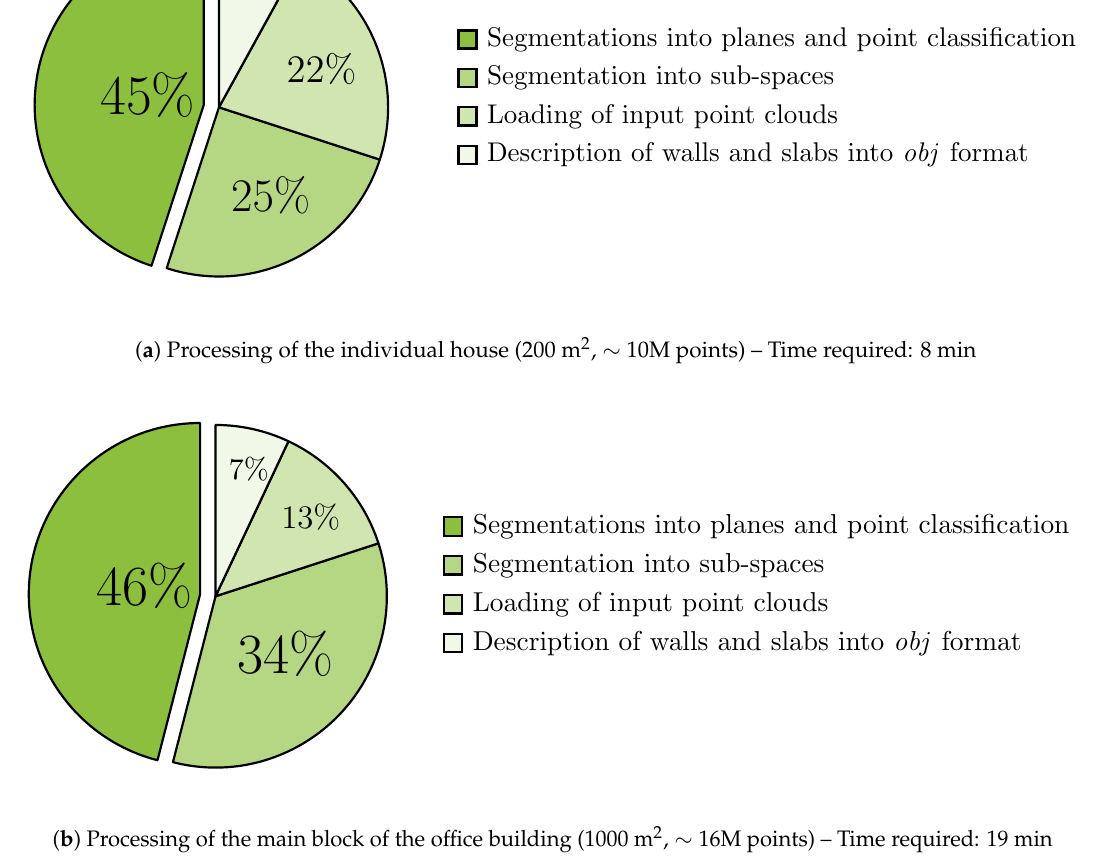
Figure 13. Repartition of the processing time regarding the main steps of the developed